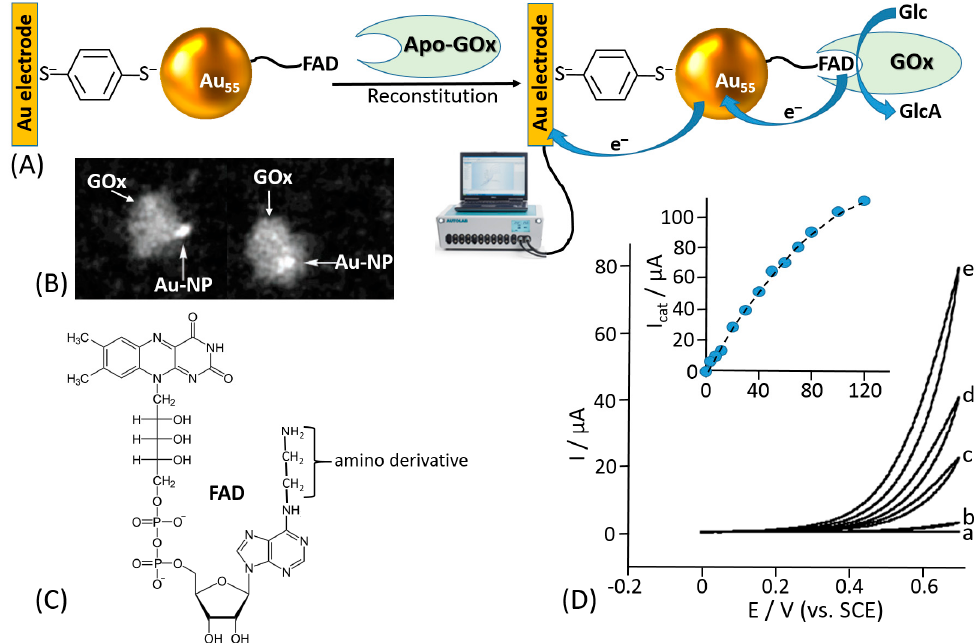
Figure 10. ( A ) Reconstitution of apo-GOx on FAD-functionalized Au nanoparticles operating as an electronically conducting nano-bridges facilitating electron transfer from the reduced FAD active center to the electrode support. ( B ) The scanning transmission electron microscopy (STEM) image showing binding of a single Au nanoparticle per the GOx enzyme molecule. ( C ) The synthetic FAD amino-derivative structure (note an additional amino group connected to the adenine with a spacer composed of two methylene groups). ( D ) Cyclic voltammograms corresponding to the bioelectrocatalyzed oxidation of glucose by the reconstituted GOx in the presence of different glucose concentrations: (a) 0 mM, (b) 1 mM, (c) 10 mM, (d) 20 mM, and (e) 50 mM. Results were recorded in 0.1 M phosphate buffer (pH 7.0), under Ar, potential scan rate 5 mV s − 1 . Inset: Calibration plot derived from the cyclic voltammograms at E = 0.6 V vs. SCE. (Part D was adopted from [155] with permission.).